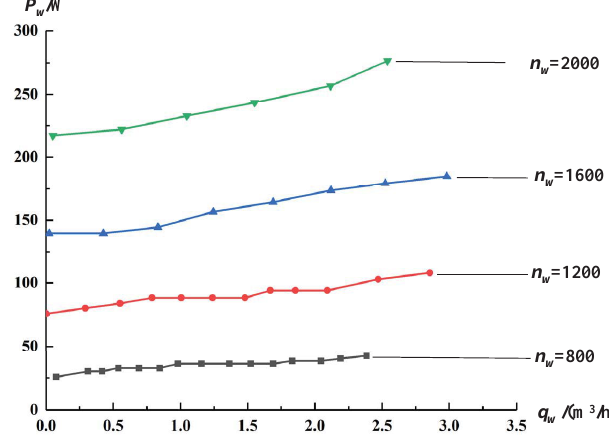
Figure 7. Power characteristics of the water pump.